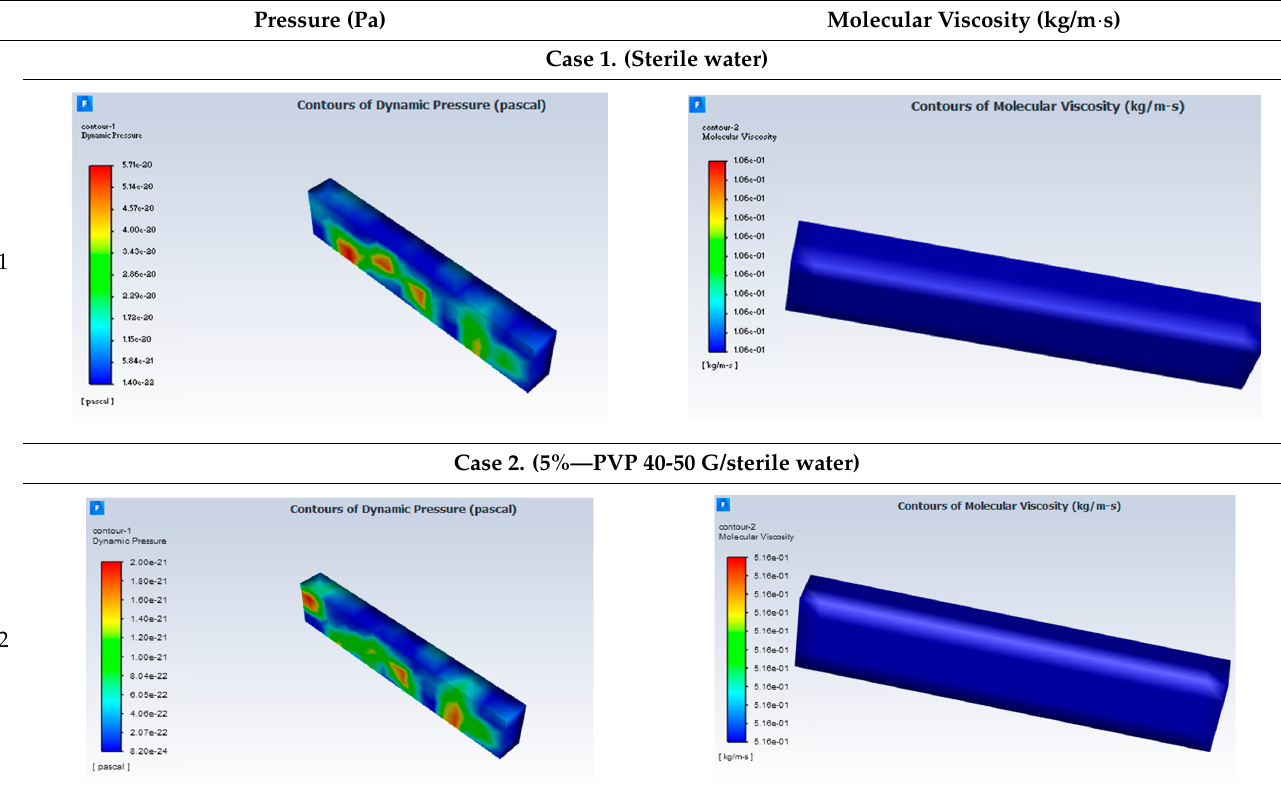
Table 3. Graphical form of the numerical analysis results for different samples. Pressure (Pa)